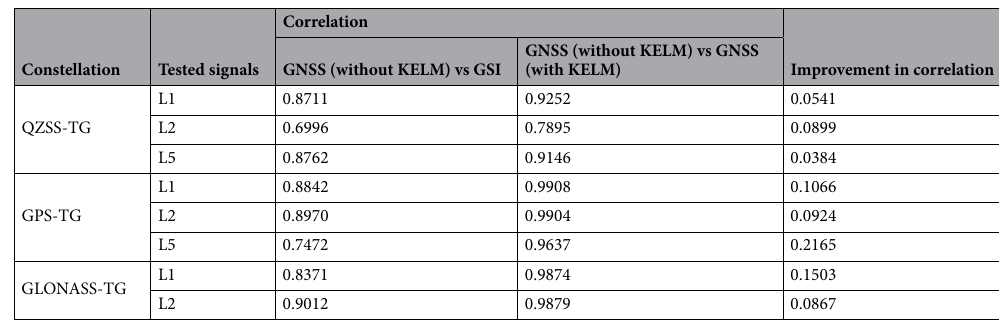
Table 3. GNSS measurement correlation coefficient and their improvement after KELM implication.